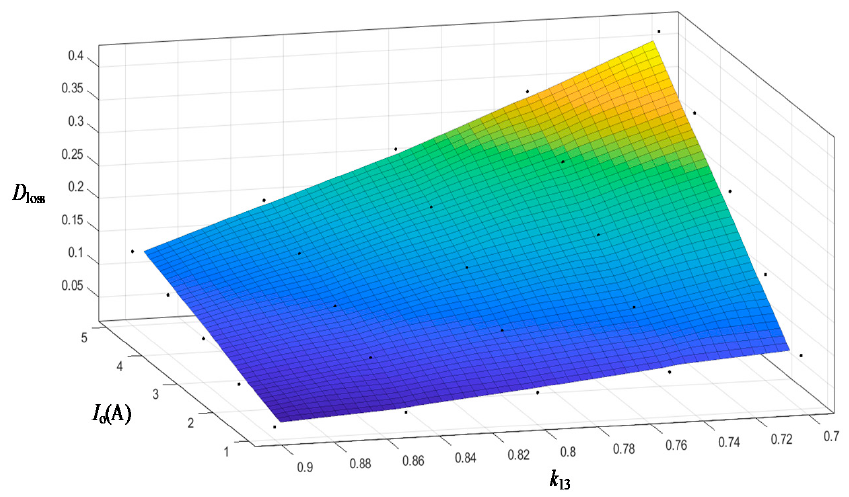
Figure 12. Relationships among k 13 , the load currents, and D loss.